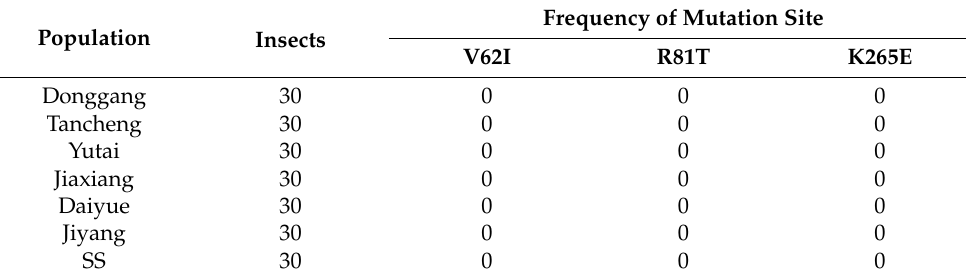
Table 10. The nAChR β 1 subunit gene mutation sites and frequency in six L. striatellus populations from Shandong